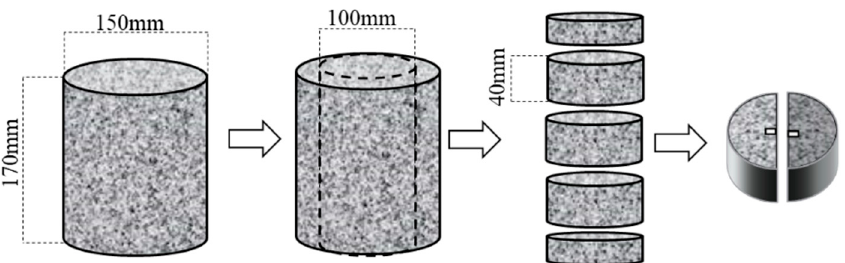
Figure 1. SCB specimen preparation.